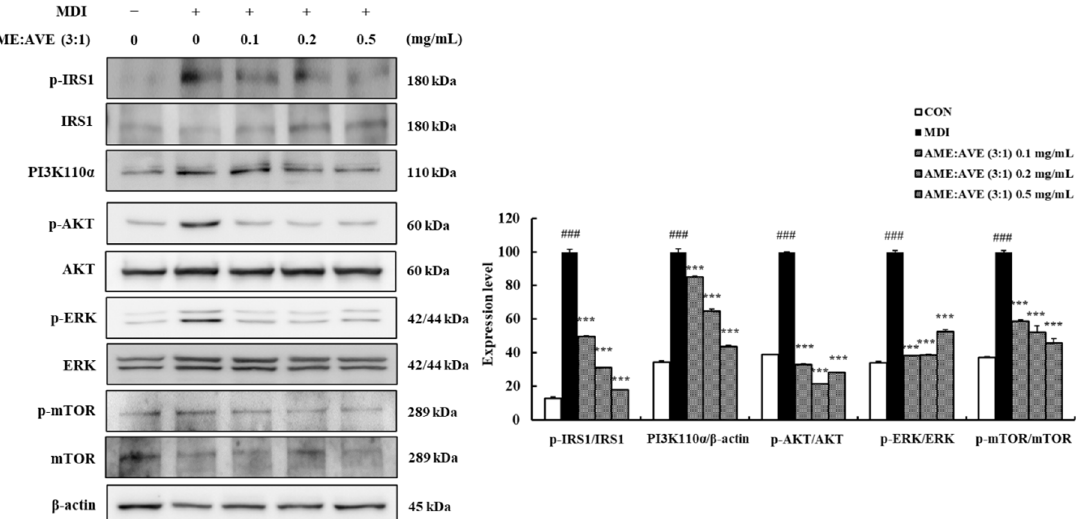
Figure 4. Effects of treatment with Atractylodes macrocephala and Amomum villosum extracts (3:1) on upstream expression of proteins related to adipogenesis and lipogenesis in 3T3-L1 adipocytes. Western blot bands were analyzed using Image J software. β -actin and total-form was used as a control for normalization. Data represent mean ± SD of three independent experiments. CON, only dimethyl sulfoxide (DMSO) treated no differentiation control; MDI, only 3-isobutyl-1-methylxanthine, dexamethasone, and insulin treated differentiation control. ### p < 0.001 vs. CON group. *** p < 0.001 vs. MDI